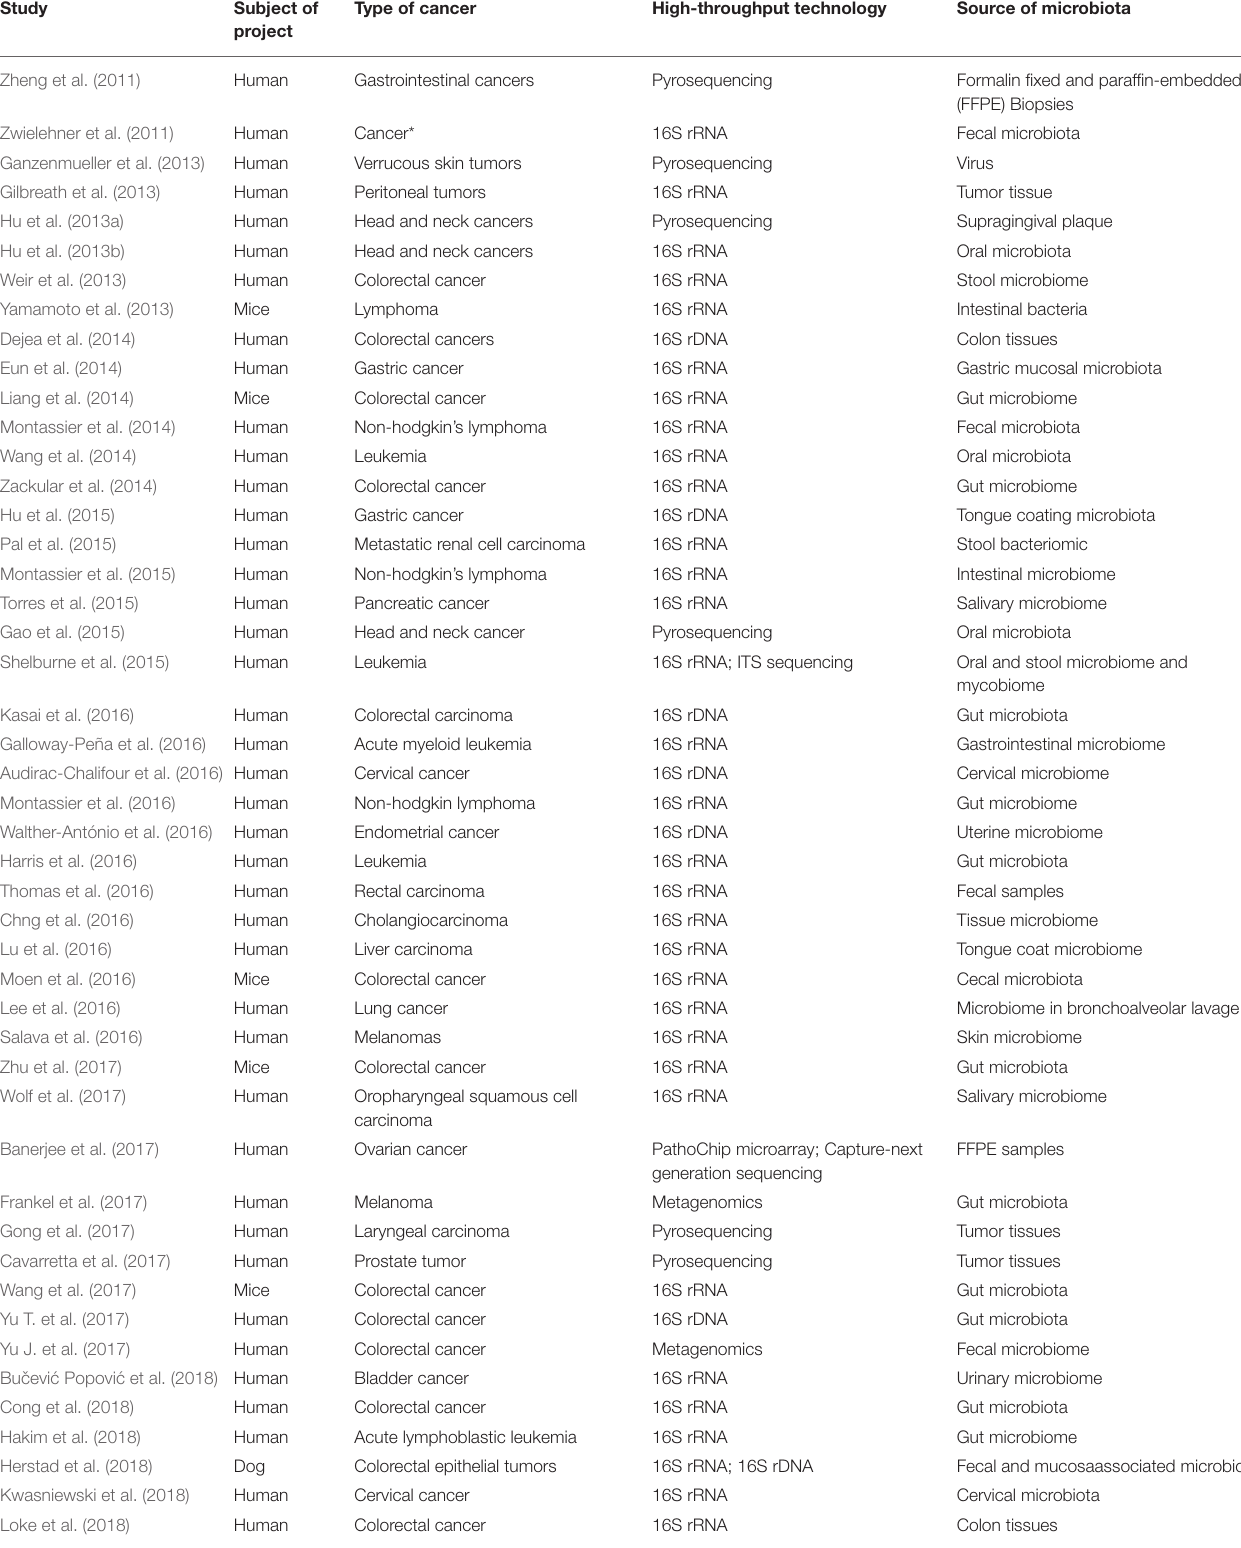
TABLE 1 | Characteristics of included